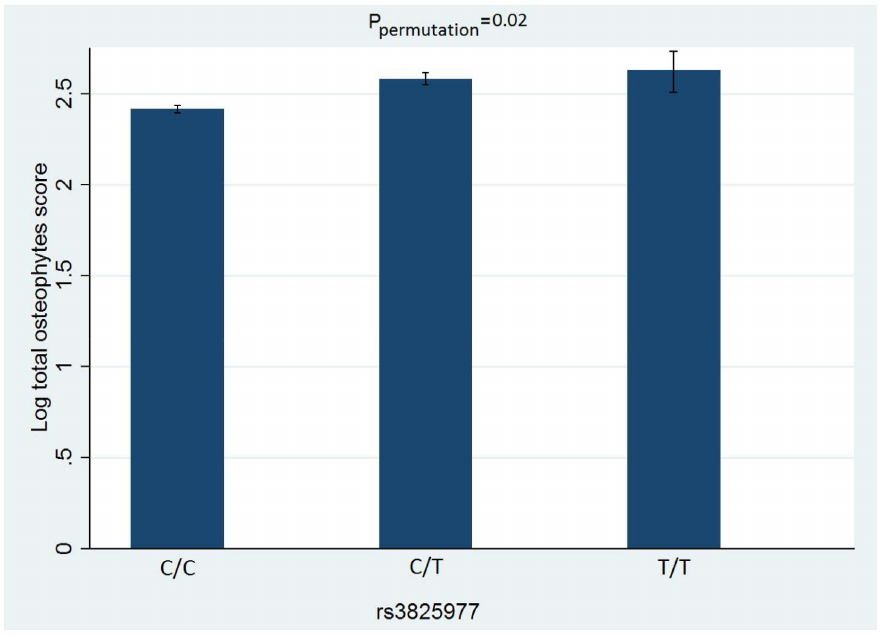
Figure 3. Total osteophyte and each genotype of rs3825977. Error bars indicate Standard Error of the mean.